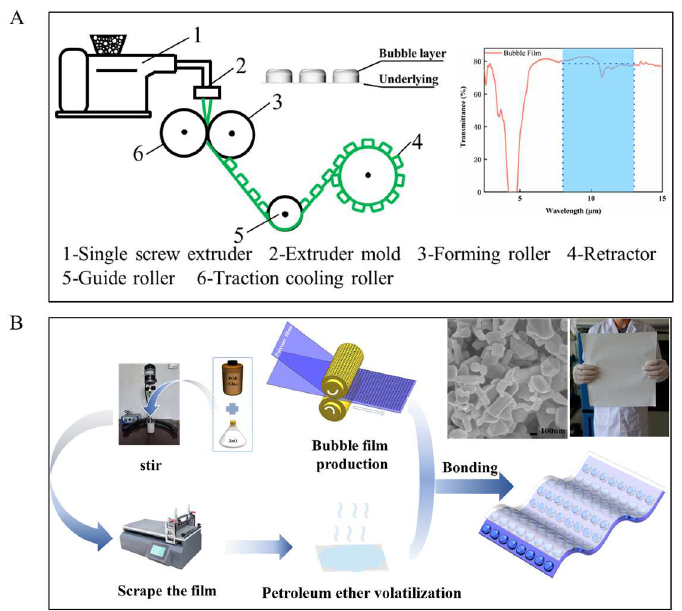
Figure 2. ( A ) Schematic diagram of the production process of PE bubble film, including measured transmittance of PE bubble film (2 mm thick) over MIR wavelength. ( B ) Schematic diagram of the production process of HPF, including the SEM photo of the upper surface of